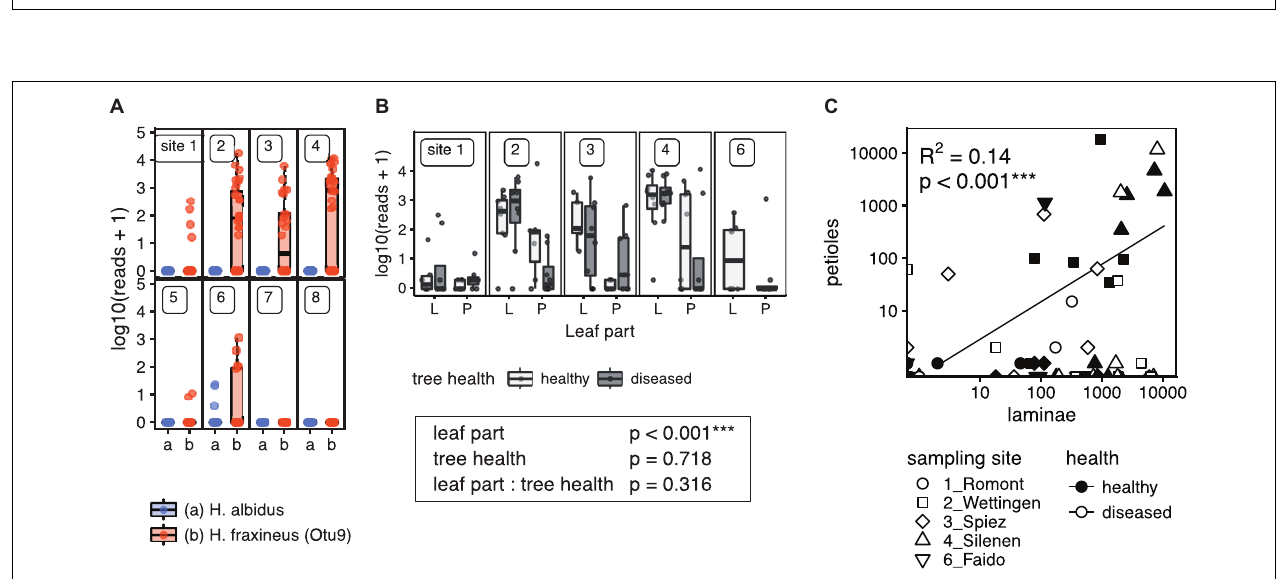
FIGURE 8 | Host specificity of dominant leaf endophyte groups. Phylogenetic trees of Venturia spp. and Mycosphaerellaceae OTUs (numbers in brackets) and published sequences are shown along pie charts illustrating the abundance distribution of NGS reads between different host species. The OTU occurrence is shown for each sampling site on both sides of the Alps, scaled according to the average number of normalized reads. The host species that were actually sampled at these locations are indicated below with colored bars. The gray pie charts indicate the abundance distribution between laminae and petioles, averaged over all samples. The numbers on the pie charts indicate the number of Venturia isolates from Ibrahim et al. (2016). The isolate codes ( Supplementary Data Sheet 2 ) are shown in gray (with % deviation of OTU from isolate sequence). OTUs from two new Venturia species on A. pseudoplatanus are highlighted by a yellow background. V. fraxini OTUs 1 and 2 matched the same isolate sequences because their sequences differed only near the 3 (cid:48) end, which did not overlap with the isolate sequences. The trees include ML bootstrap percentages next to branches. The scale bars represent the number of substitutions per site.